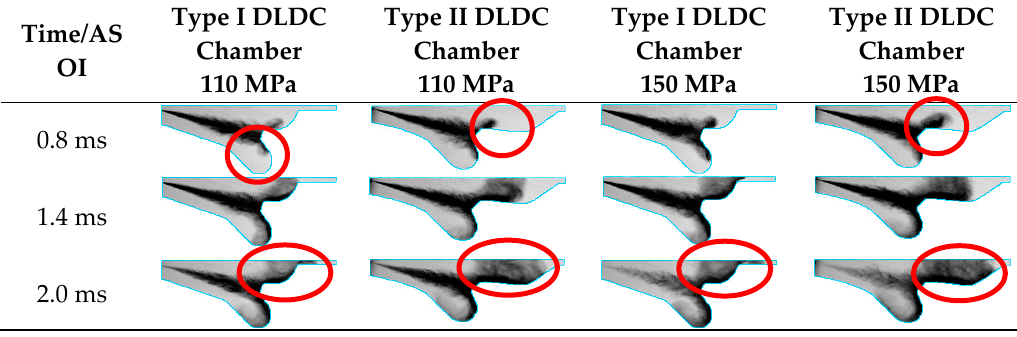
Figure 9. The comparison of fuel spray distributions between the two DLDC chambers with medium load, Φ 0.16 mm nozzle, different injection pressures and 5 °CA BTDC injection timing of Mode A.